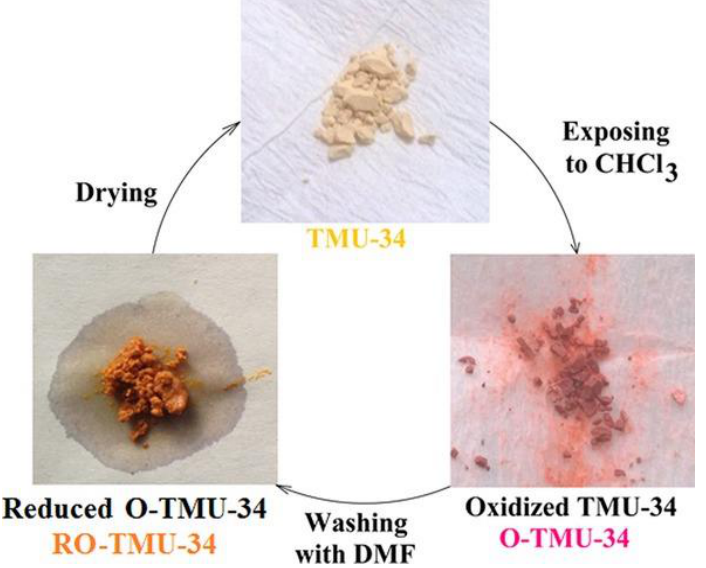
Figure 3. Sensing cycle for TMU-34, which is transformed, upon exposure to ChCl3, into O-TMU-34 which reverts back to TMU-34 after regenerating with DMF. Reprinted with permission from Ref [159], copyright 2017 John Wiley and Sons.